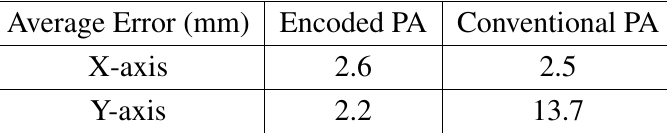
Table 1. Algorithms accuracy : Average error in radial and lateral axes after one hundred